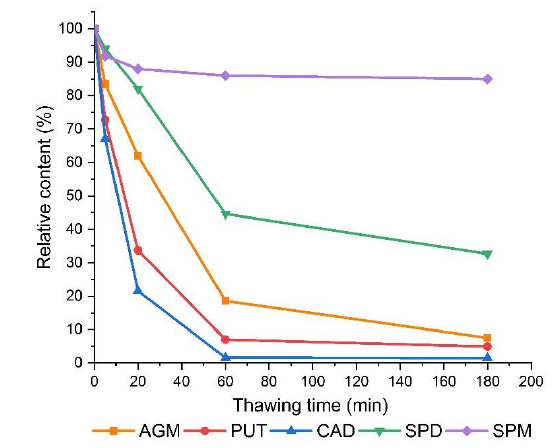
Figure 3. Time-dependent changes in the content of polyamines (agmatine (AGM), putrescine (PUT), cadaverine (CAD), spermidine (SPD), and spermine (SPM)) during thawing of the frozen fenugreek sprouts.